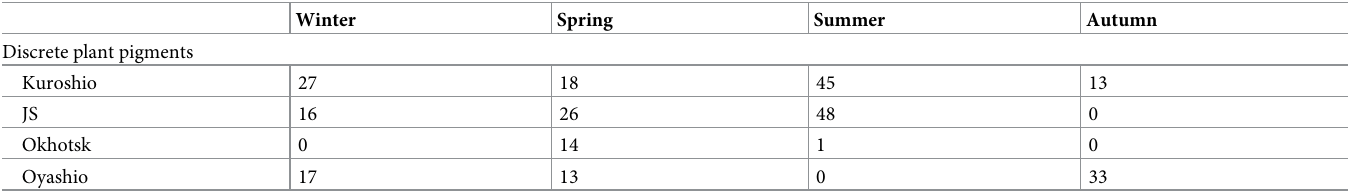
Table 1. List of the number of samples used for discrete plant pigment analysis. Winter Spring Summer